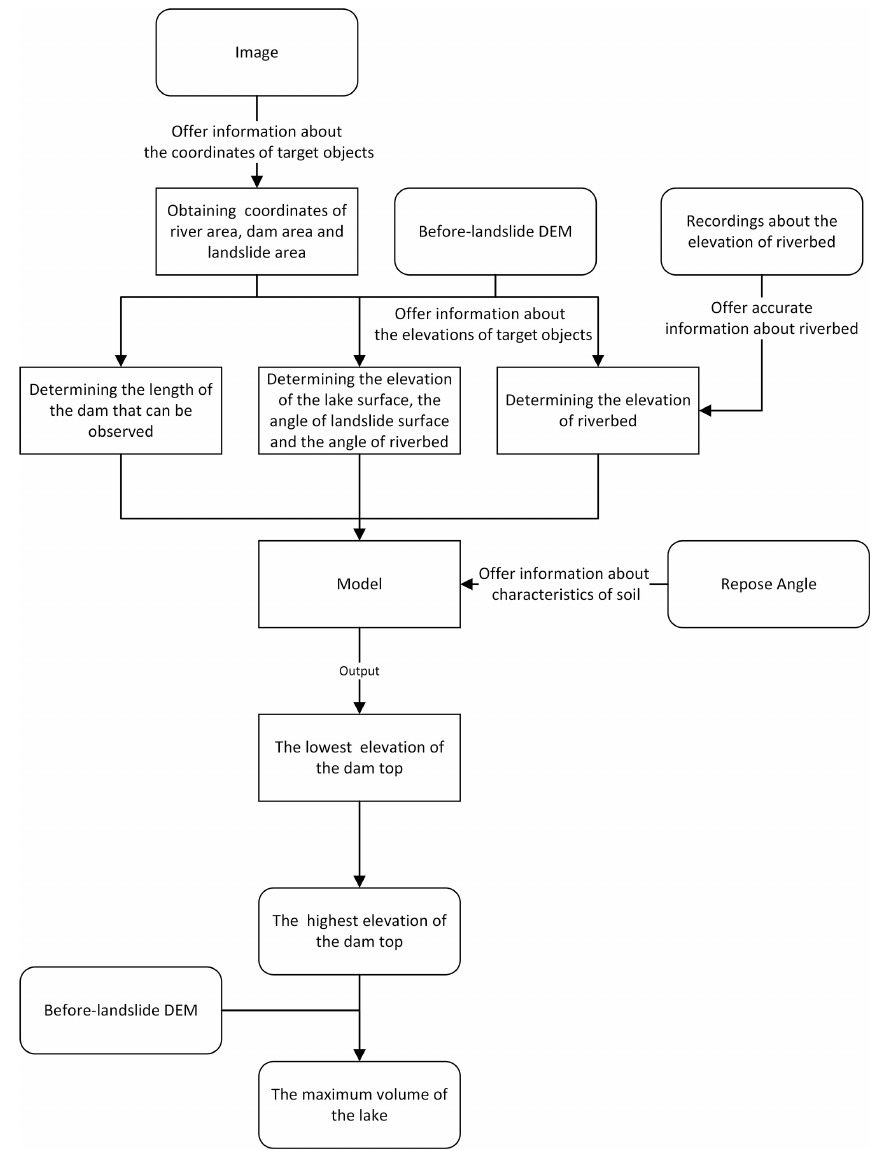
Figure 13. The complete process of parameter